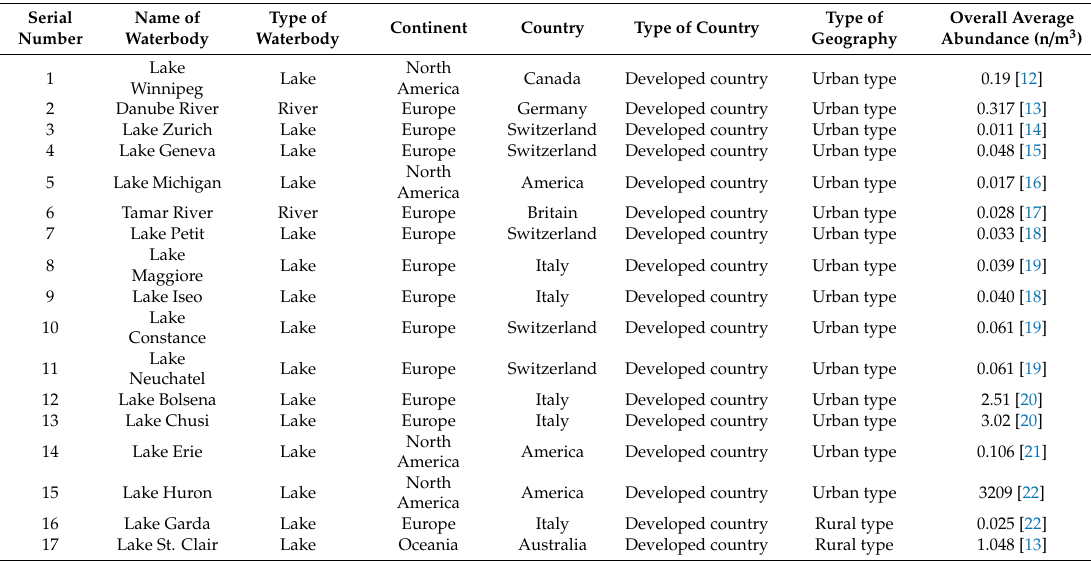
Table 1. Research sample information